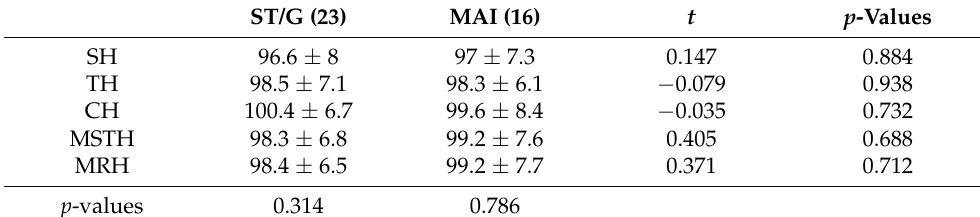
Table 2. Differences in the LSI between